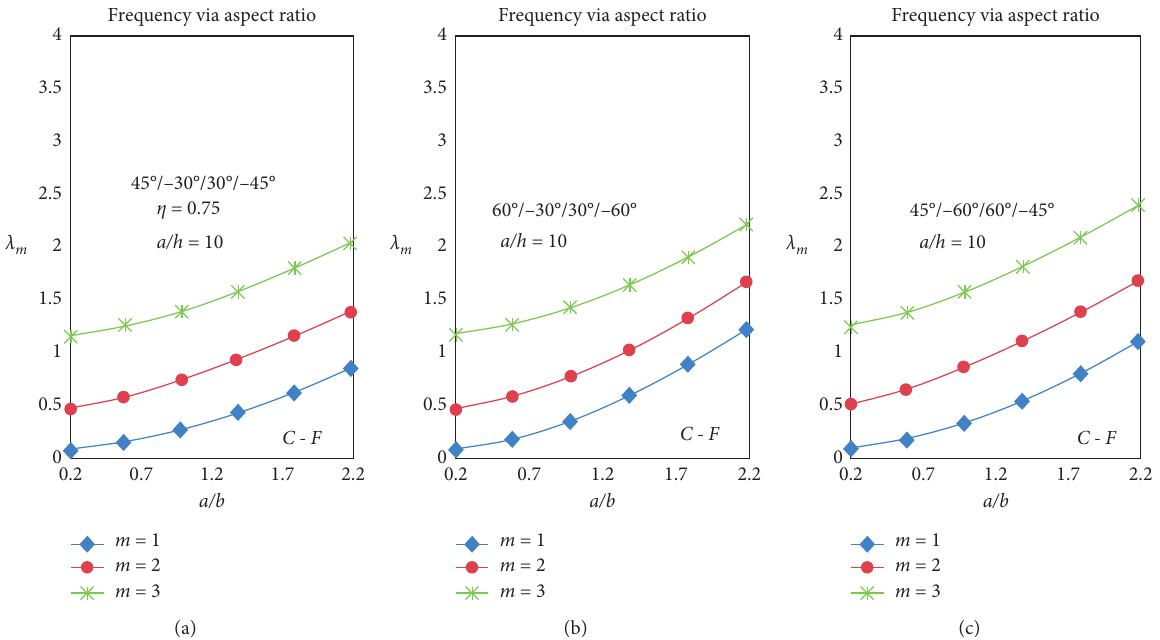
Figure 17: Influence of aspect ratio on frequency parameter value of 4-layered plates under C-F support